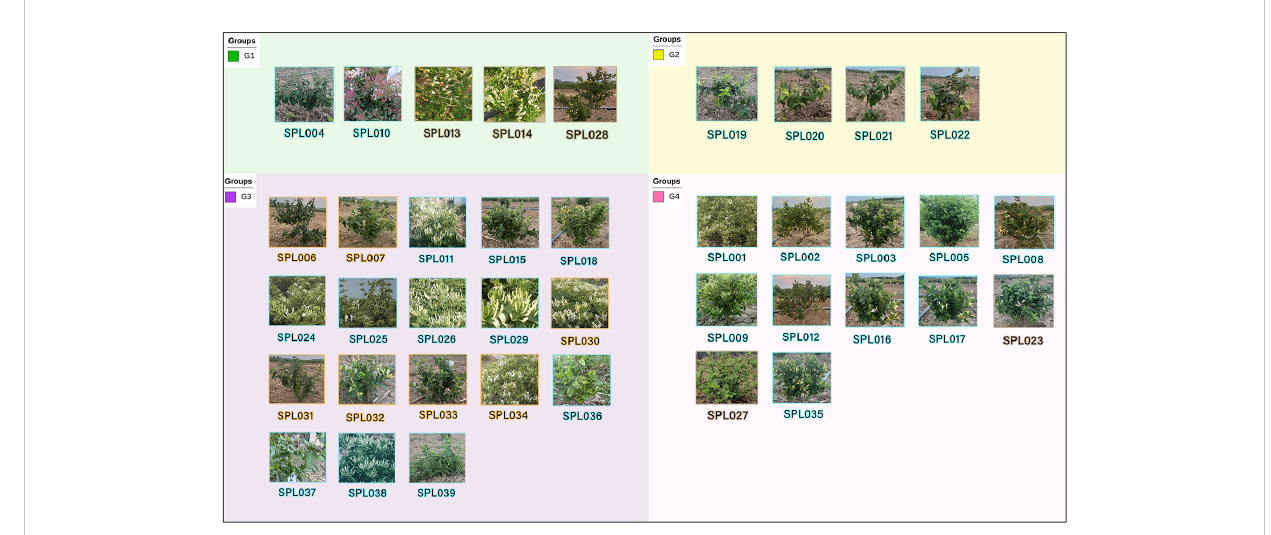
FIGURE 1 Simpli fi ed genome sequencing of 39 wild and cultivated varieties of L. japonica and L. macranthoides in China. Groups G1, G3, and G4 are L. japonica and Group G2 is L. macranthoides . Blue represents cultivar, orange represents wild, and brown represents